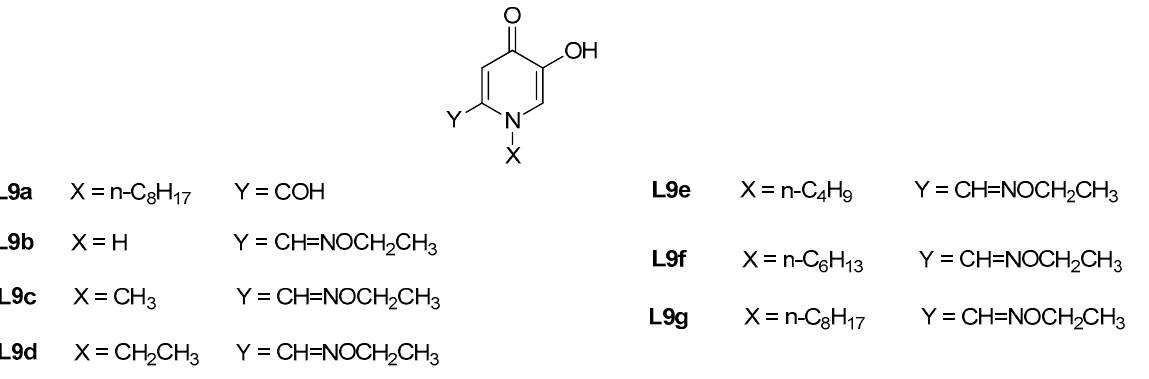
Figure 5. Bis-3-hydroxy-4-pyridinones employed for possible environmental applications. The reported thermodynamic studies on the mentioned bis-3-hydroxy-4-pyridinones (L) and the speciation models revealed the formation of stable mononuclear and binuclear protonated species (M p L q H r ; p, q = 1-2, r = 1-4) with 1:1 and 1:2 stoichiometry (ML, ML 2 ), as well as mixed hydroxo (MLOH, M 2 L 2 (OH) 2 ) species at the highest pH ranges. The presence of polynuclear complex species was detected in the case of L10 and L11 . Since these complexes should not be formed at the trace concentration in which the pL 0.5 is calculated, this parameter could not be used for comparisons between the different metal- ligand systems but only the pM values (Table 3). Table 3. pM values reported in literature for bis-3,4-HPs and commercial metal chelators. Compounds